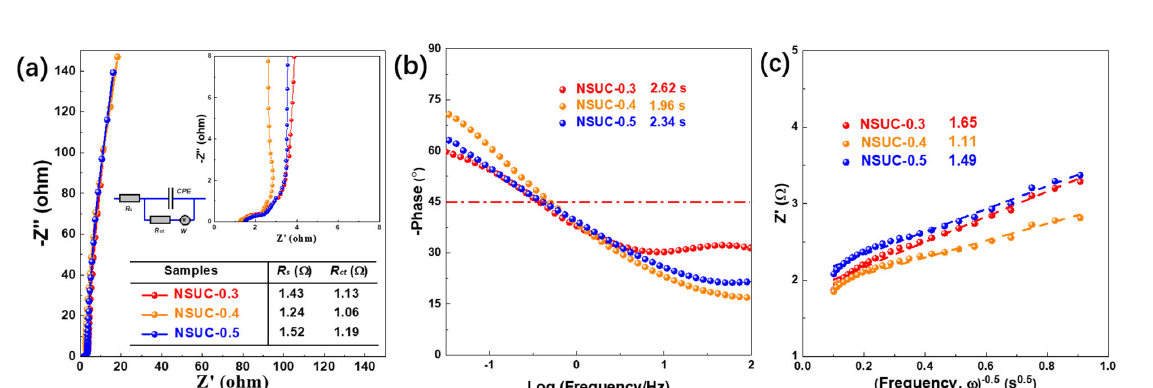
NSUC ‐ 0.4 obtained from Figure 7b,c are 1.96 s and 1.11 Ω s − 1/2 , respectively, which were lower than those of NSUC ‐ 0.3 and NSUC ‐ 0.5 [54]. These ESR, τ and σ values imply the low resistance and the fast electrolyte/ion diffusion achieved by the NSUC ‐ 0.4 electrode.